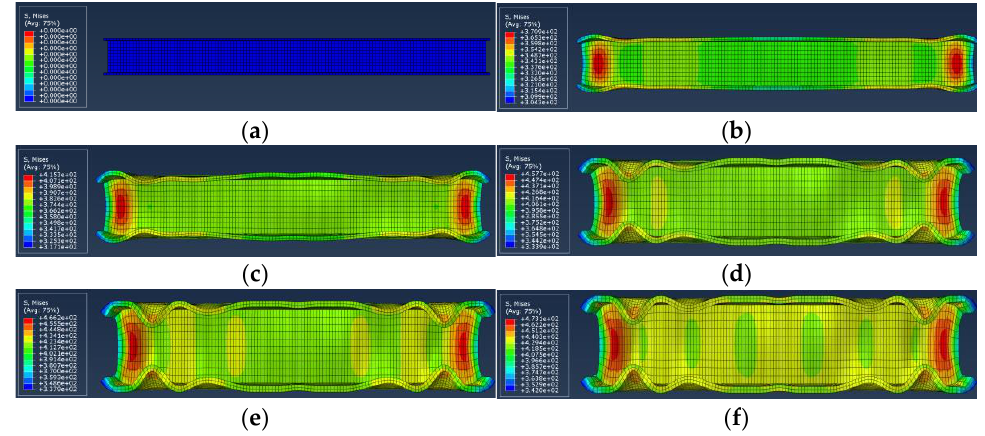
Figure 10. Buckling development of H-section steel core in compression of the first loading cycle. ( a ) ε = 0. ( b ) ε = 1.28%. ( c ) ε = − 2.18%. ( d ) ε = − 3.08%. ( e ) ε = − 3.30%. ( f ) ε = − 3.50%.